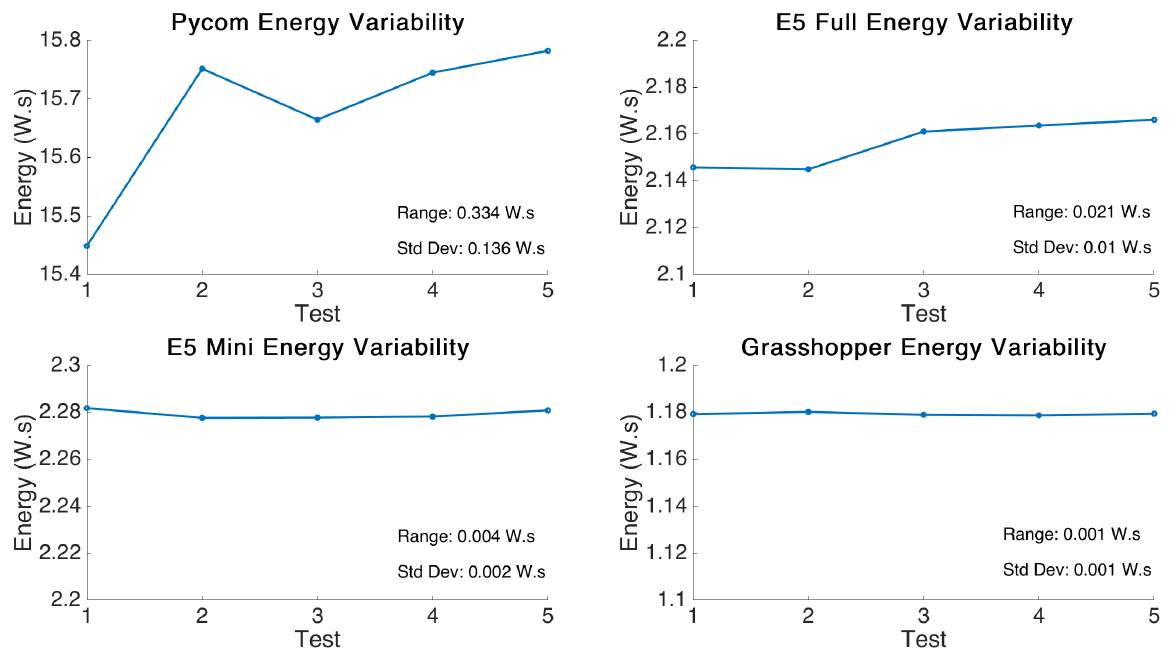
Figure 3. Multiple board total energy variability over multiple runs (calculated using individual live sample